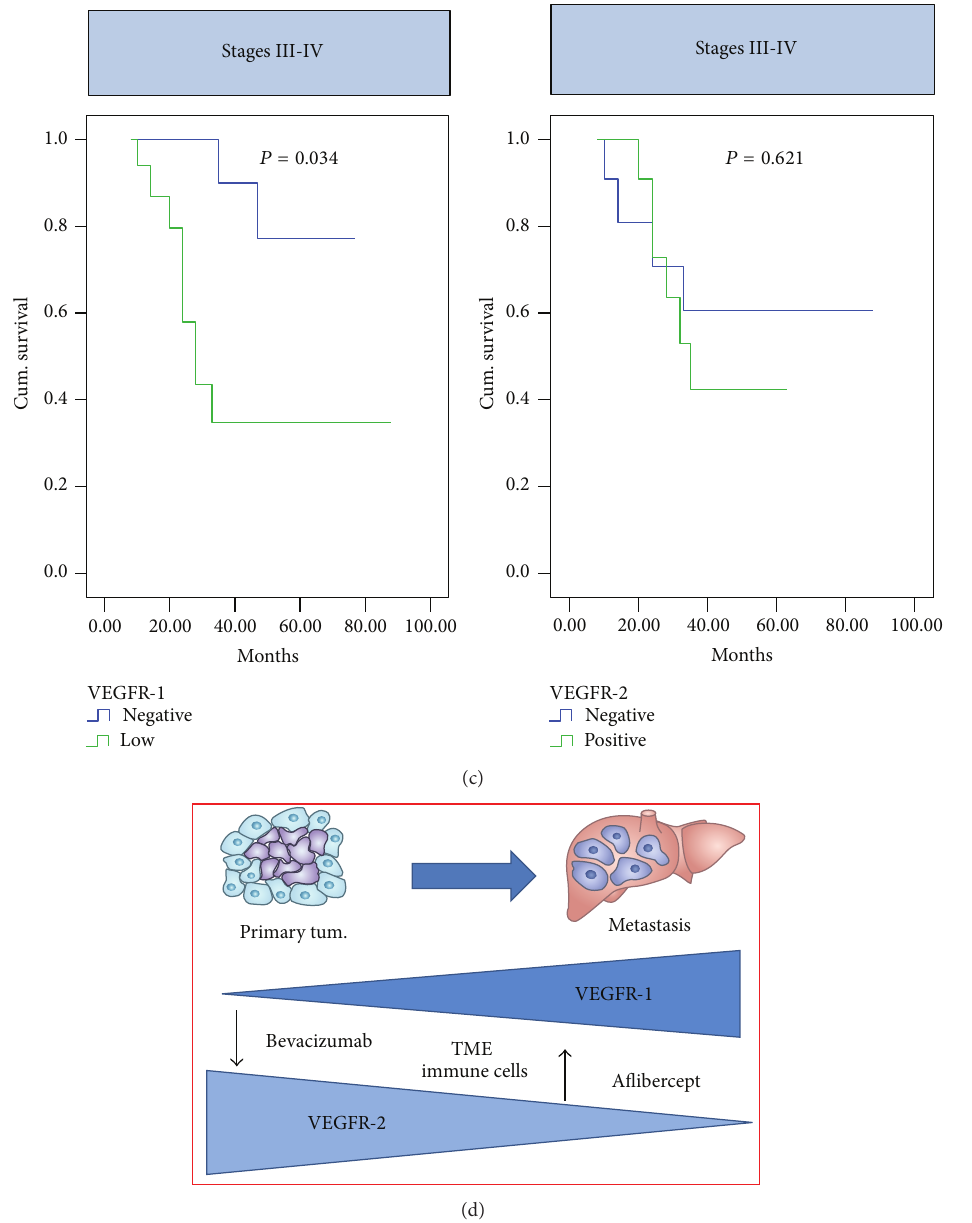
Figure 3: VEGFR-1 and VEGFR-2 differentially orchestrate the tumour-stroma interplay to promote cancer growth and metastasis. (a) RepresentativeimagesofVEGFR-1andVEGFR-2immunostaininginaprimarycoloncarcinomaandcorrespondinglivermetastasisobtained from our still unpublished observations. Yellow and black arrows indicate the immunostaining in the stromal compartment and malignant colonic cells, respectively; with magnification 10x. (b) VEGFR-1 and VEGFR-2 immunostaining differentially correlate with CD68 infiltration, a marker of M2 tumor associate macrophages (TAMs). (c) Patients’ disease specific survival in relation to VEGFR-1 and VEGFR-2 expression in our cohort of 86 CRC patients stage III-IV only (Pancione et al. unpublished data). (d) Schematic drawing of the proposed mechanism(s) involved in metastasis-promoting actions of VEGFR-1 and VEGFR-2, respectively. VEGFR-1, but not VEGFR-2, is expressed in a variety of stromal cells and appears synergized with TME in the evolution of premetastatic niche and cancer cell migration. Aflibercept targeting PlGF/VEGFR-1 axis can reduce the induction of an angiogenic rescue program and inhibit immune cells recruitment and metastatic progression. The 𝑃 value is reported in each graph. Cum. (cumulative), Met. (metastases), Neg. (negative), Pos. (positive), and Tum.